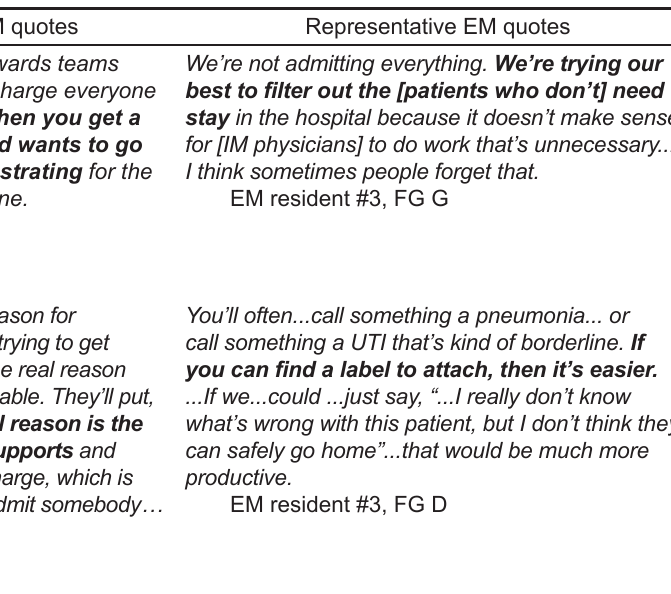
Table 2. Internal medicine and emergency physician perspectives related to disposition decisions (whether patients require admission at all, whether patients should go to the ICU rather than the IM service, or whether additional testing is necessary before transfer to the